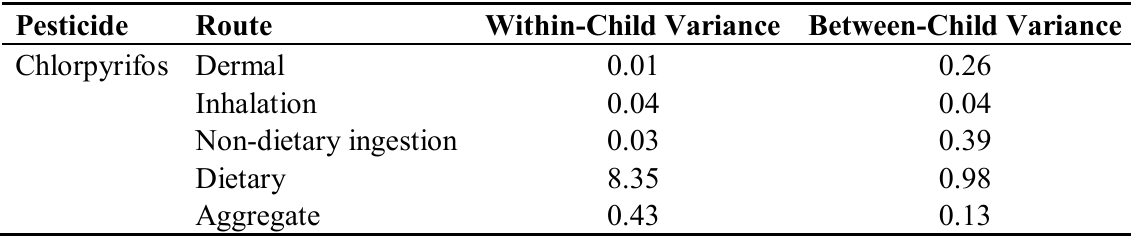
Table 7. Within-child and between-child variance calculated for the 5000 simulations for each of the 23 children according to Rappaport